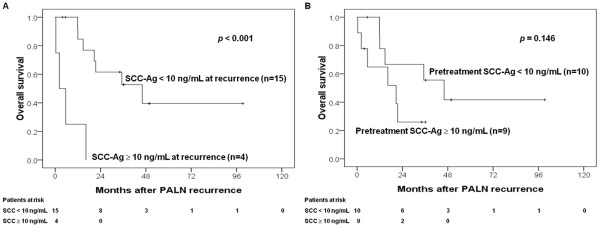
(A) SCC-Ag ≥ 10 ng/mL at recurrence but not (B) pretreatment SCC-Ag levels predicted overall survival after isolated PALN recurrence.